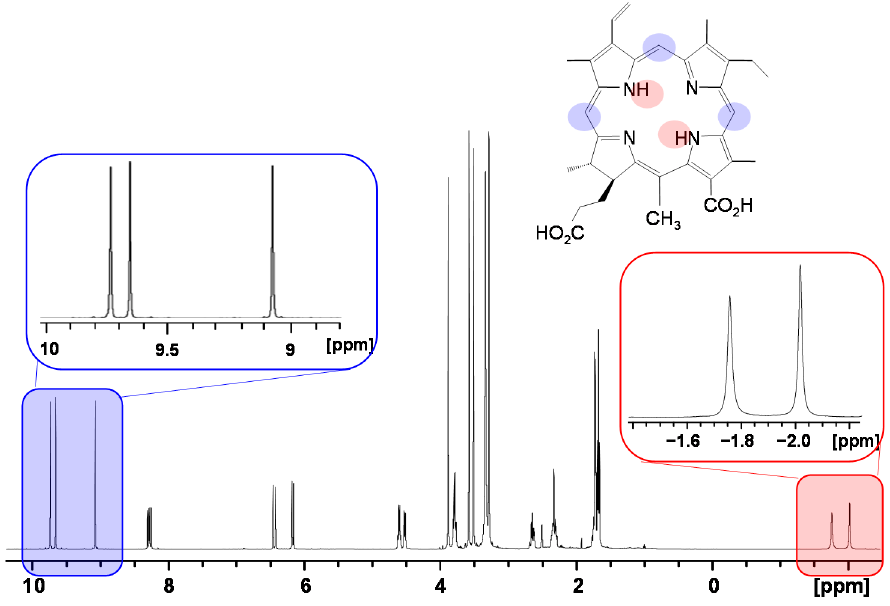
Figure 3. 1 H NMR spectrum of chlorin e4 in DMSO ‐ d 6